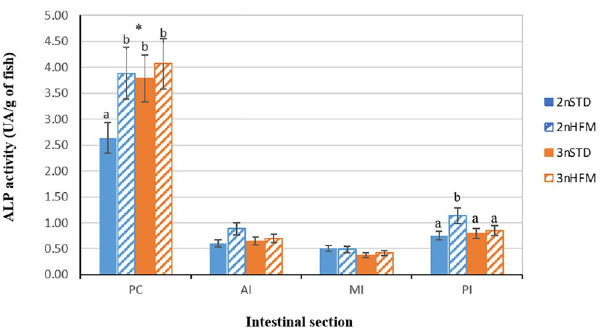
Fig 12. Alkaline phosphatase (ALP) activity (expressed as UA/g of fish) of diploid (2n) and triploid (3n) Atlantic salmon, Salmo salar , fed fish meal (STD) and hydrolysed fish protein (HFM) diets measured at 2745 ddPSF sampling point (see Table 1: 38 weeks after start feeding). Four intestinal sections were considered: pyloric caeca (PC), anterior intestine (AI), medium intestine (MI) and posterior intestine (PI). Different letters denote significant differences (P < 0.05). Data are presented as means ± SE (n = 15). ( � ) Indicates significant differences between 2n and 3n in each section (P < 0.05).